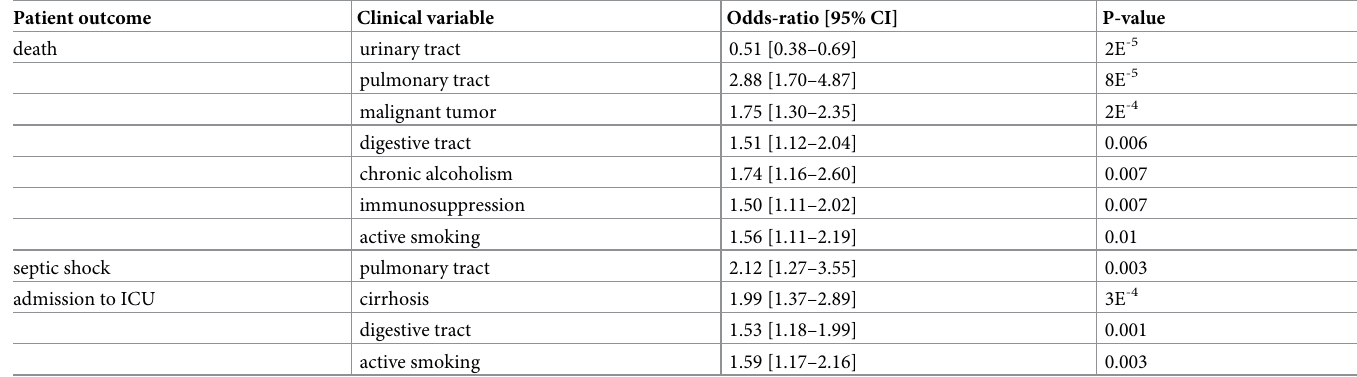
Table 1. Univariate analysis on the combined dataset. Only clinical variables significantly associated with BSI outcomes are shown. CI, confidence interval.